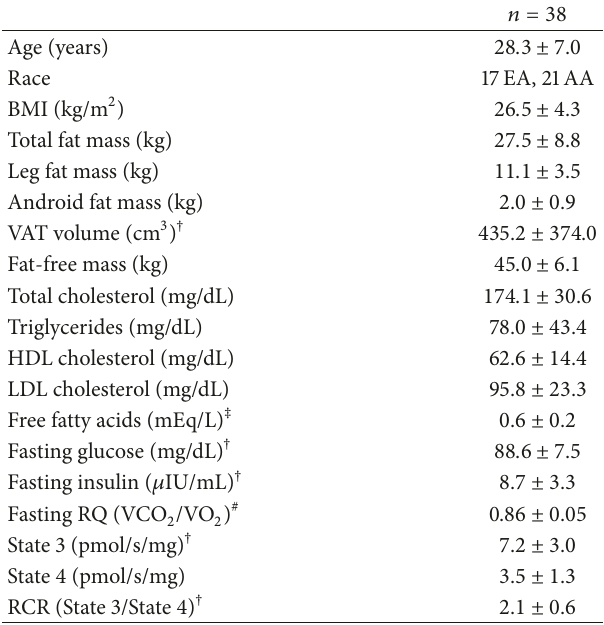
Table 1: Participant characteristics.